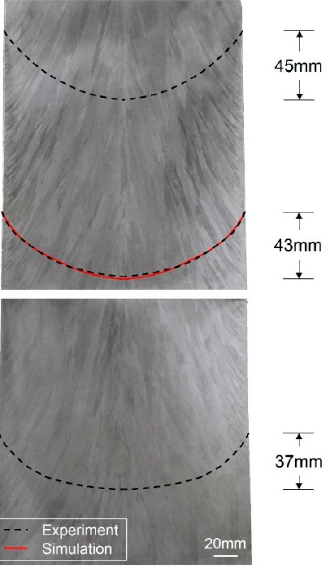
Figure 6. Comparison of metal pool profiles between experiment and simulation.